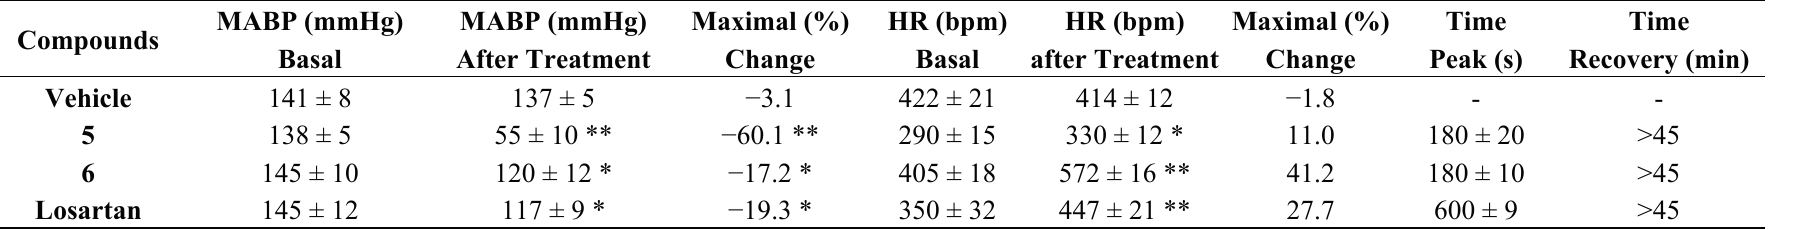
Table 1. Effects of compounds 5 and 6 isolated from Licania cruegeriana on the mean arterial blood pressure (MABP) and heart rate (HR) of spontaneously hypertensive rats (SHR).